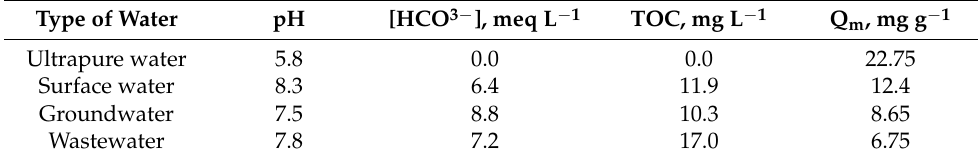
Table 6. Composition of natural waters used in the study.